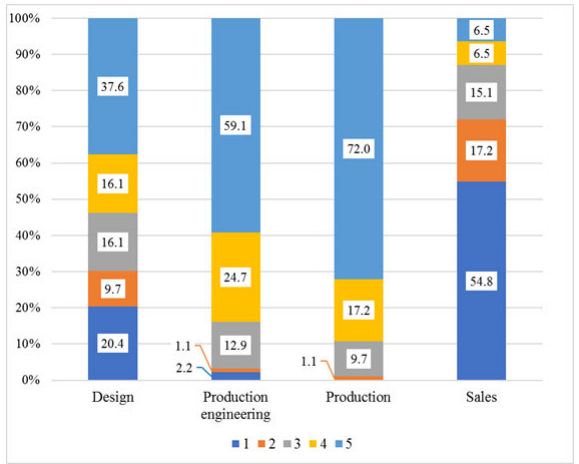
Figure 1. Self-containment of functions